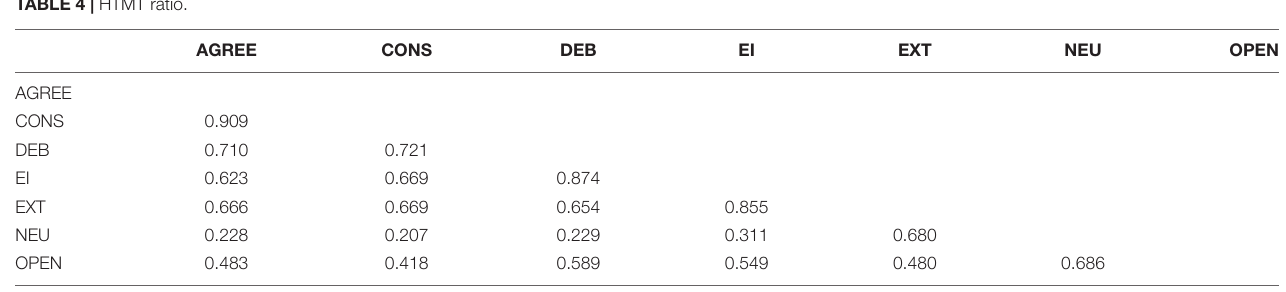
TABLE 4 | HTMT ratio.